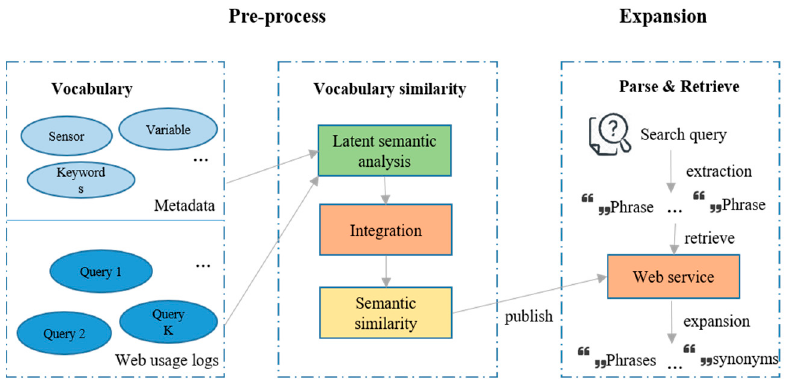
Figure 6. Workflow of query expansion.